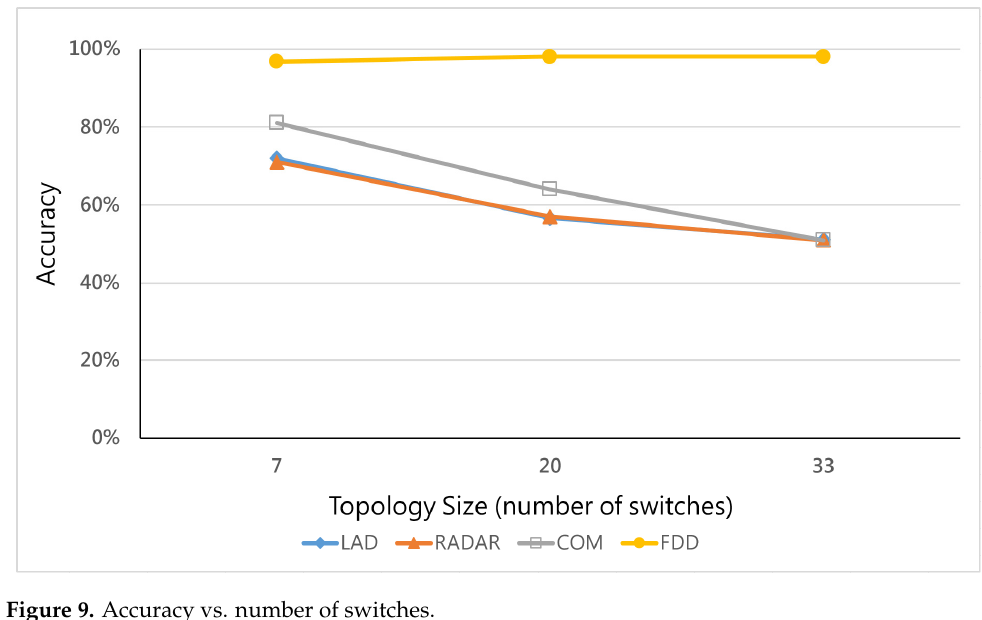
Figure 9. Accuracy vs. number of switches.